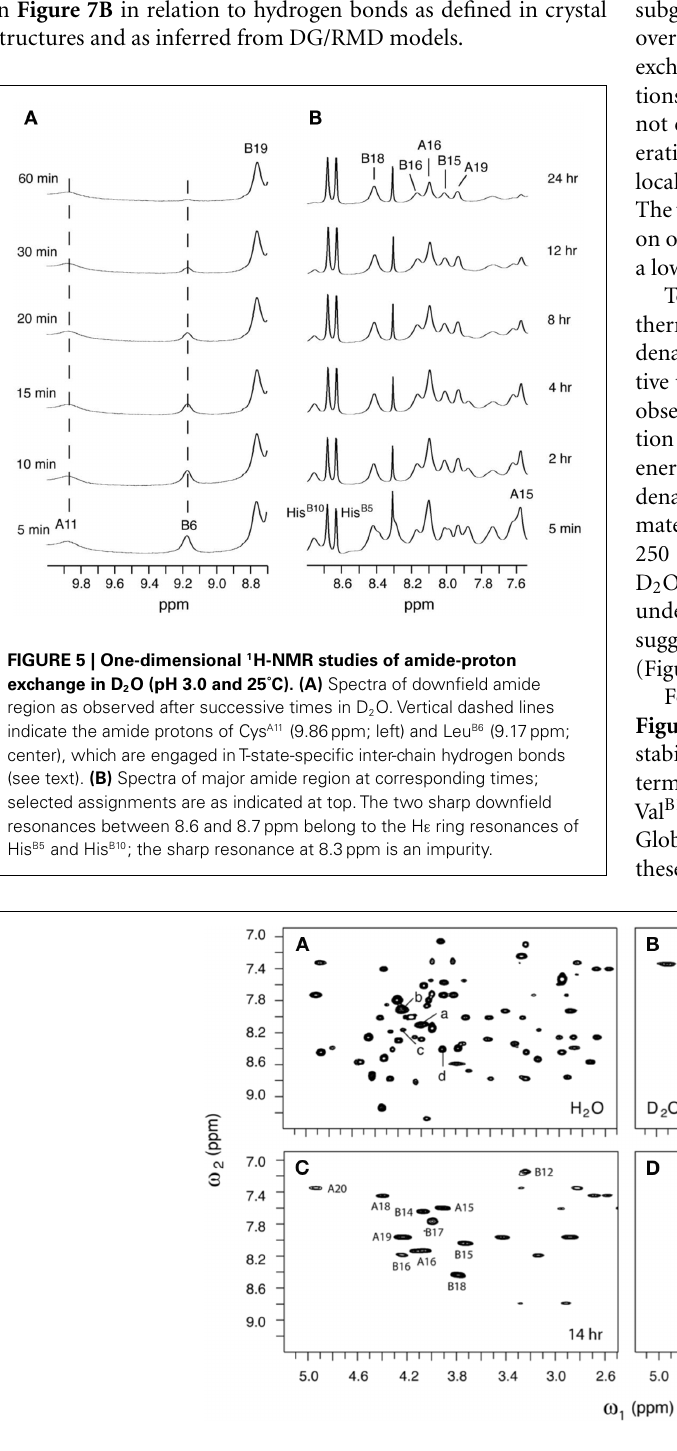
and (d)Val B18 . (B–D) TOCSY spectra as acquired at successive times after dissolution in D 2 O: (B) 2h, (C) 14h, and (D) 48h. Assignments are as